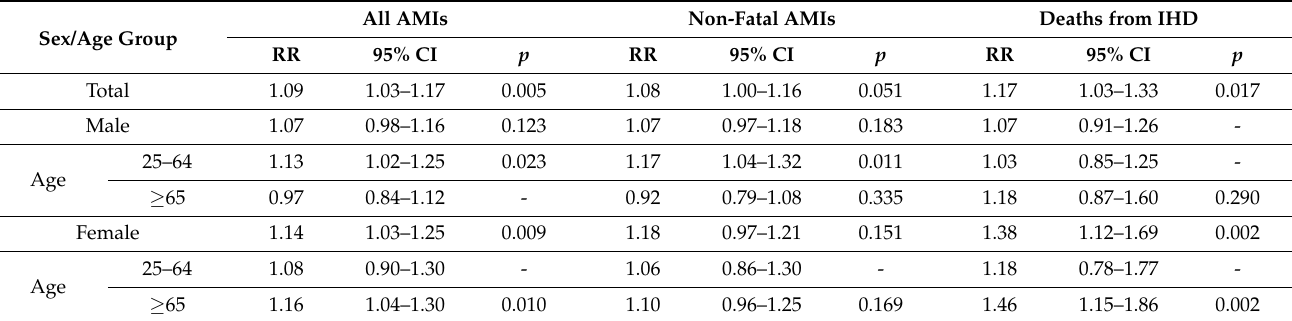
Table 7. The effect of ICMEs (the period of days 2–4 of ICMEs) on the risk of AMIs and deaths from IHD by sex and age group. Sex/Age Group